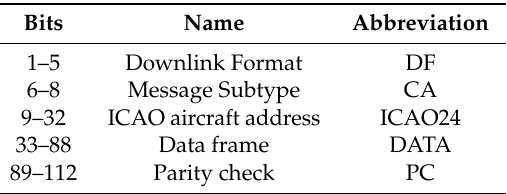
Table 2. ADS-B message